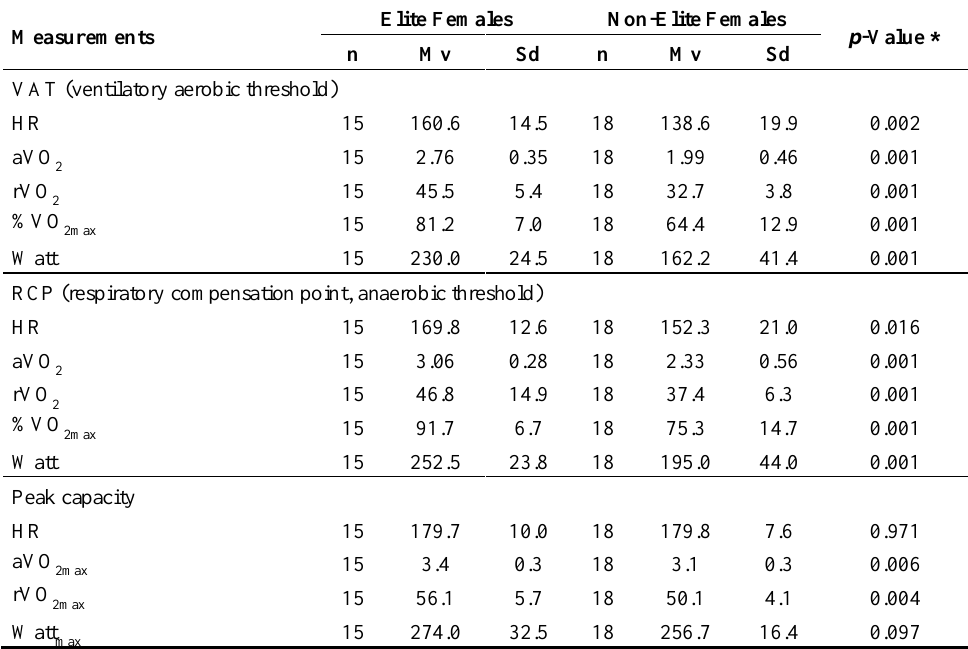
Table 6. Females: heart rate, oxygen uptake and power output according to performance. Elite Measurements